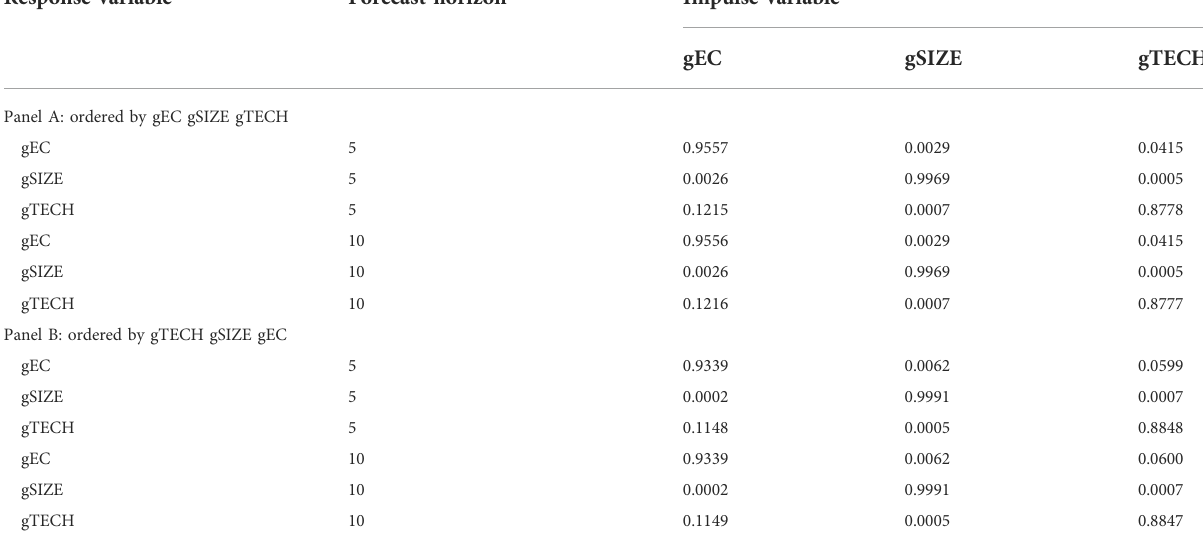
TABLE 6 Variance decomposition. Response